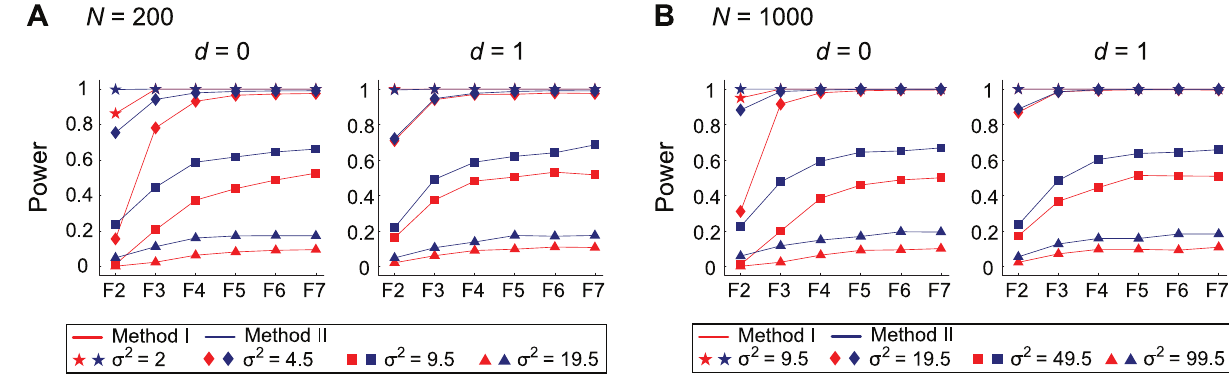
Figure 2. The power of QTL mapping as a function of the number of inbreeding generations. a N ~ 200 and b N ~ 1000 are assumed. The red and blue lines are for the results of Method I and Method II, respectively. See text for